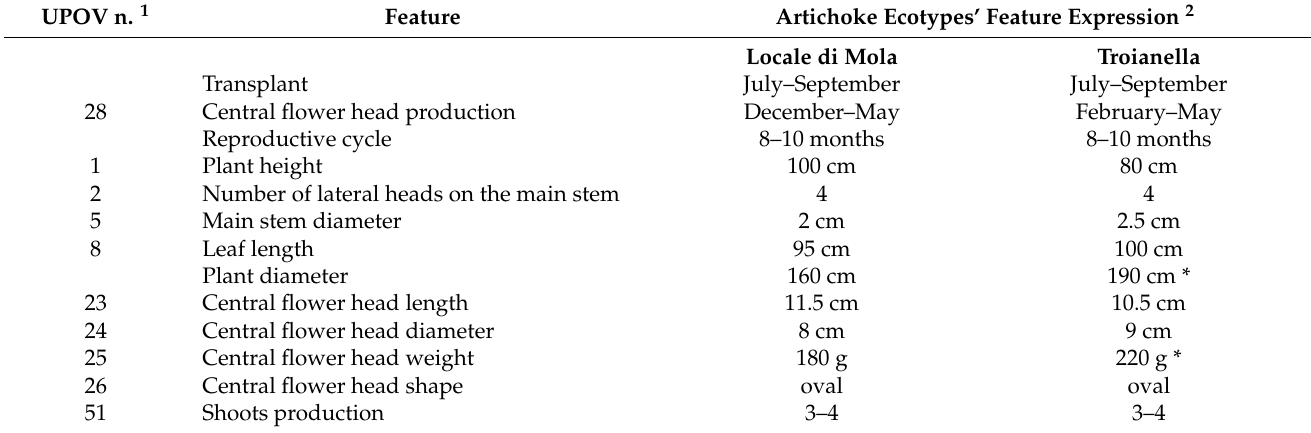
Table 1. Morphological and qualitative traits of Locale di Mola and Troianella artichoke ecotypes. UPOV n.